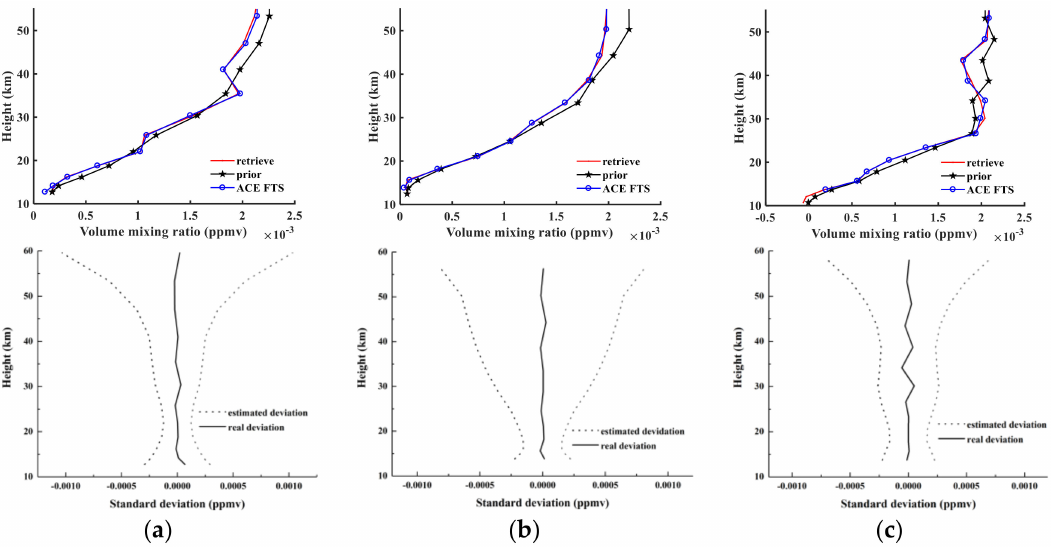
Figure 15. The same as Figure 9 but for HF.